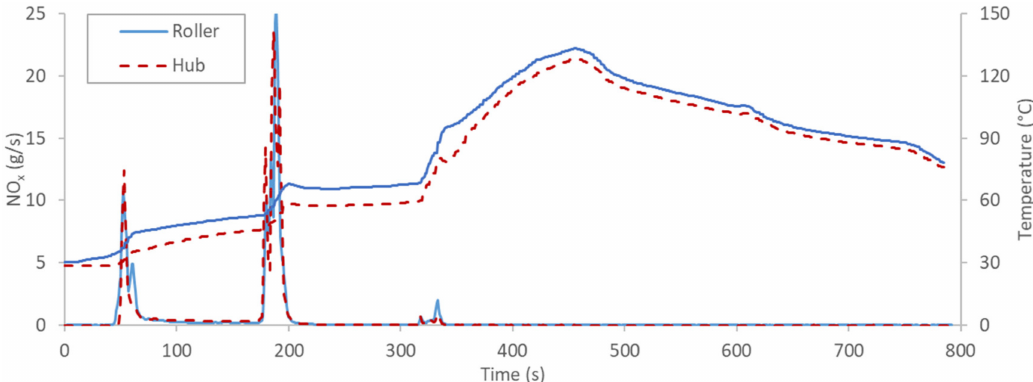
Figure A2. NO x real-time emissions during the speed ramp